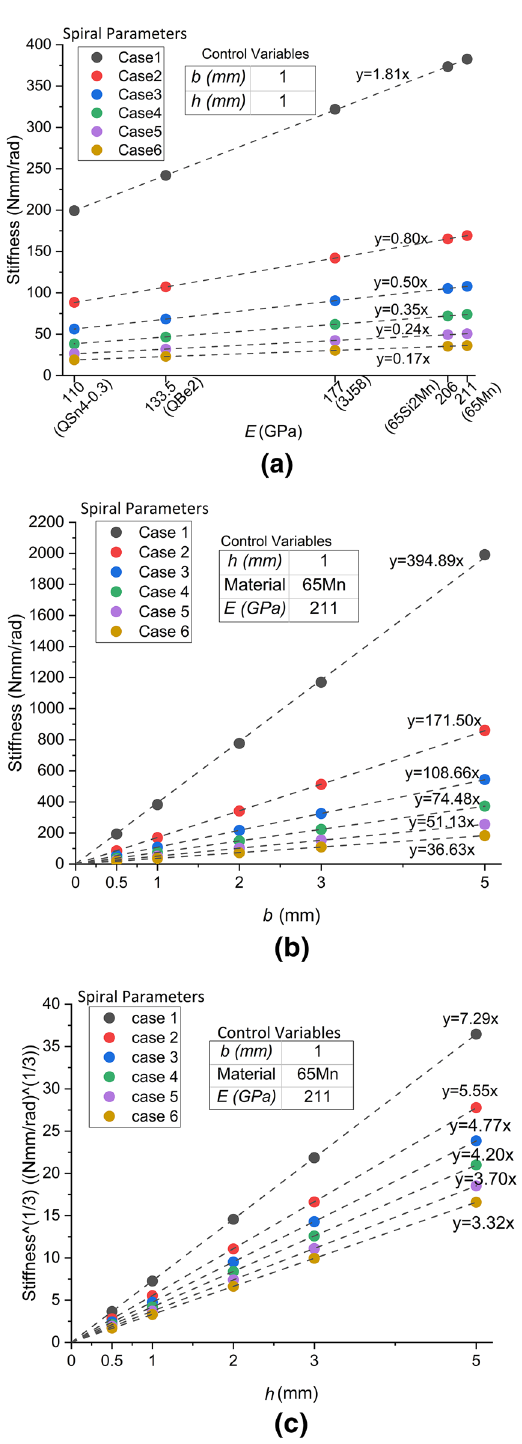
Figure 4. Relation between the stiffness from FEA of spring arms and the elastic modulus, thickness and width. ( a ) Stiffness from FEA versus elastic modulus of materials; ( b ) Stiffness from FEA versus thickness; ( c ) Stiffness from FEA versus